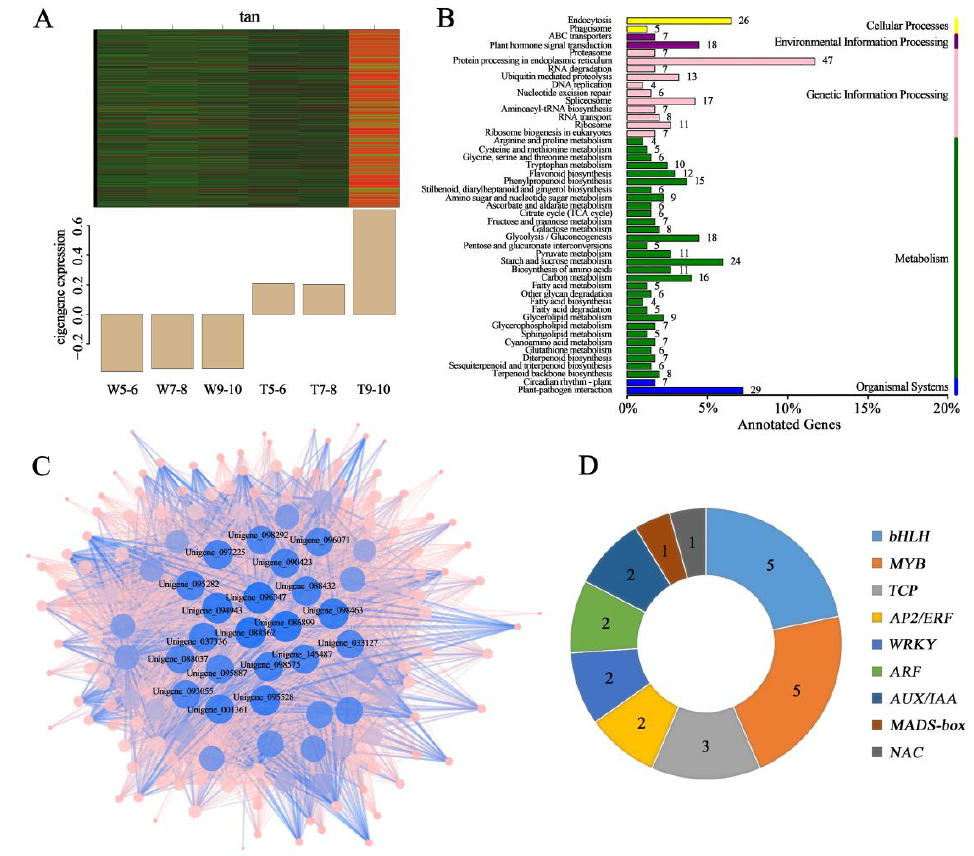
Figure 5. The expression pattern, annotation, and network prediction of genes in the tan module. ( A ) Expression pattern of eigengenes in the tan module. ( B ) KEGG pathways significantly enriching genes in the tan module. ( C ) Network of the top 50 hub genes from the tan module, which showed high correlation with carotenoid accumulation. ( D ) Statistics on the number of important transcription factors in the tan module.